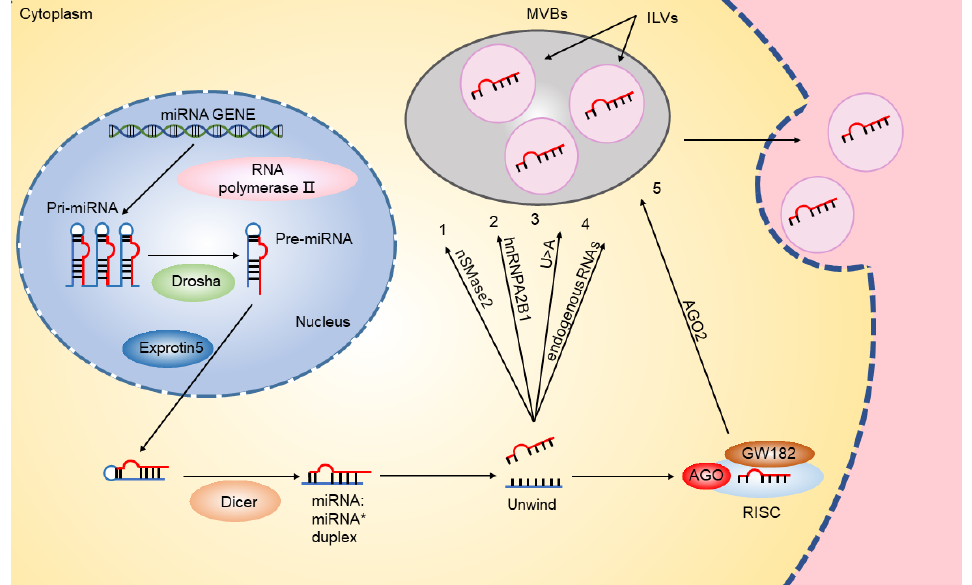
Figure 2. Generation of miRNAs and their sorting mechanisms. In the nucleus, miRNA is first transcribed by polymerase II to produce Pri-miRNA. The ribonuclease type III enzyme Drosha processes Pri-miRNAs to produce hairpin precursors (pre-miRNAs) composed of about 70 nucleotides. Pre-miRNA hairpins are exported to the cytoplasm by EXPORTIN5 and Rnase Ⅲ protein Dicer further works Pre-miRNA into 19–25 nt miRNA double stranded structure. The two less stable strands of the double strand are merged into a multi-protein nuclease complex, the RNA-induced silencing complex (RISC). Mature miRNAs are sorted into exosomes through five mechanisms: (1) Sphingomyelinase 2-dependent pathway. (2) miRNA motifs dependent pathway. (3) 3’-end modification of miRNA-dependent pathway. (4) Endogenous RNA-mediated pathway. (5) miRISC-related pathways. AGO: argonaute RISC catalytic component; GW182, trinucleotide repeat containing adaptor 6A; hnRNPA2B1, heterogeneous nuclear ribonucleoprotein A2/B1; miRISC, miRNA induced silencing complex; MVB, multivesicular body; ILV, intraluminal vesicle.